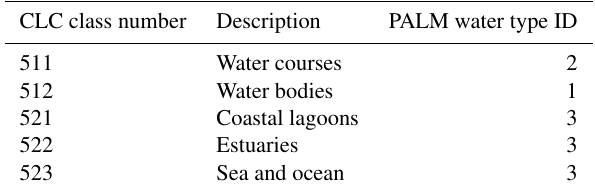
Table B10. CLC classes to PALM water